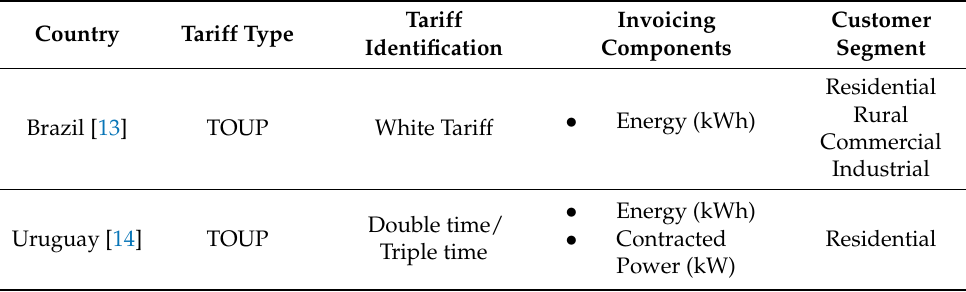
Table 2. South American experiences in time tariffs.